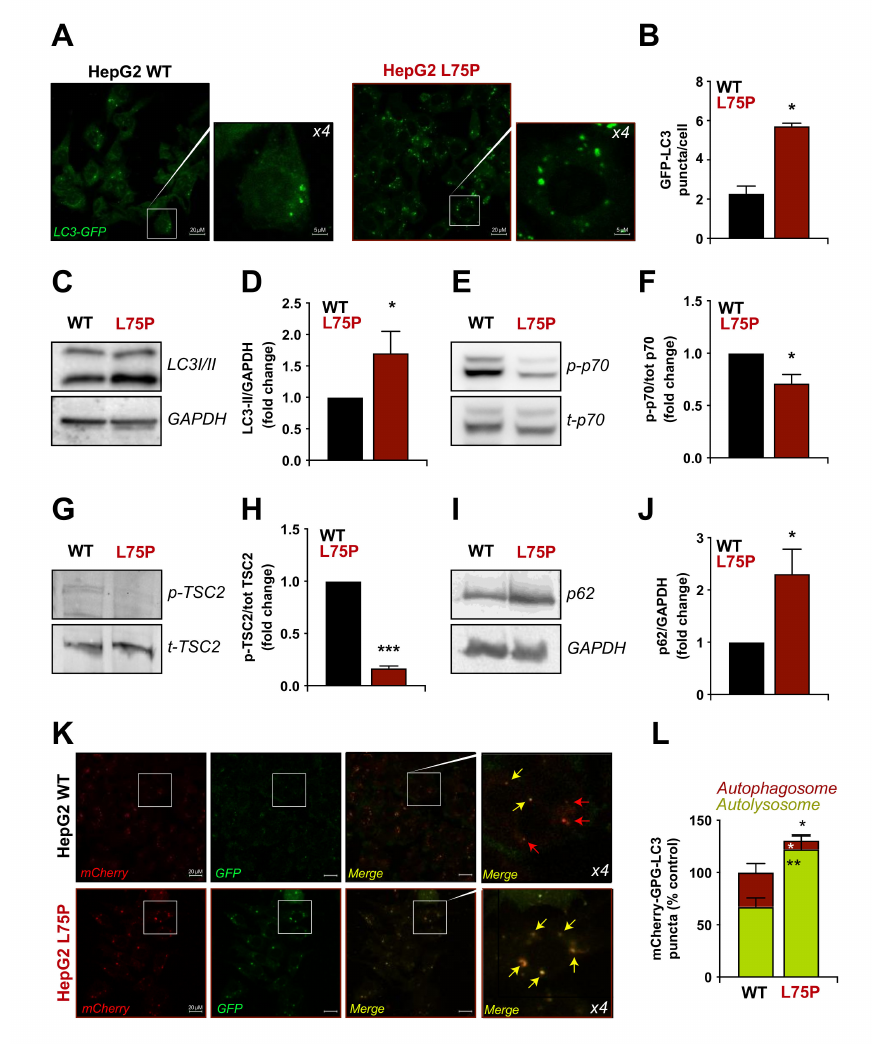
Figure 2. Measurement of autophagy in L75P-ApoA-I expressing cells. ( A , B ). Wild type (WT) and L75P-ApoA-I (L75P) HepG2 cells were transiently transfected with GFP-LC3, maintained in control conditions and the number of cytoplasmic GFP-LC3 dots per cell was quantified. ( C – J ). WT and L75P HepG2 cells were maintained in control conditions. Thereafter, LC3 lipidation ( C ), p70 ( E ) and TSC2 ( G ) phosphorylation as well as p62 levels ( I , J ) were quantified by immunoblot. GAPDH levels ( D – I ), total p70 (t-p70) ( E ) or total TSC2 (t-TSC2) ( G ) levels were monitored to ensure equal loading of lanes, and densitometry was employed to quantify the abundance of lipidated LC3 (LC3-II) ( D ), p70 ( F ) and TSC2 ( H ) phosphorylation and p62 ( J ). ( K , L ). WT and L75P HepG2 cells were transfected with the empty vector or pDest-mCherry-GFP-LC3B plasmid. After 24 h, the number of yellow vesicles (autophagosomes) and red vesicles (autolysosomes) was quantified. Images are from one experiment and representative of three independent experiments made in triplicates. If not previously specified, the panels in this figure are shown as means ± SD of at least three independent experiments. Asterisks symbols indicate significant changes with respect to WT cells (* p < 0.05, ** p < 0.01, *** p <